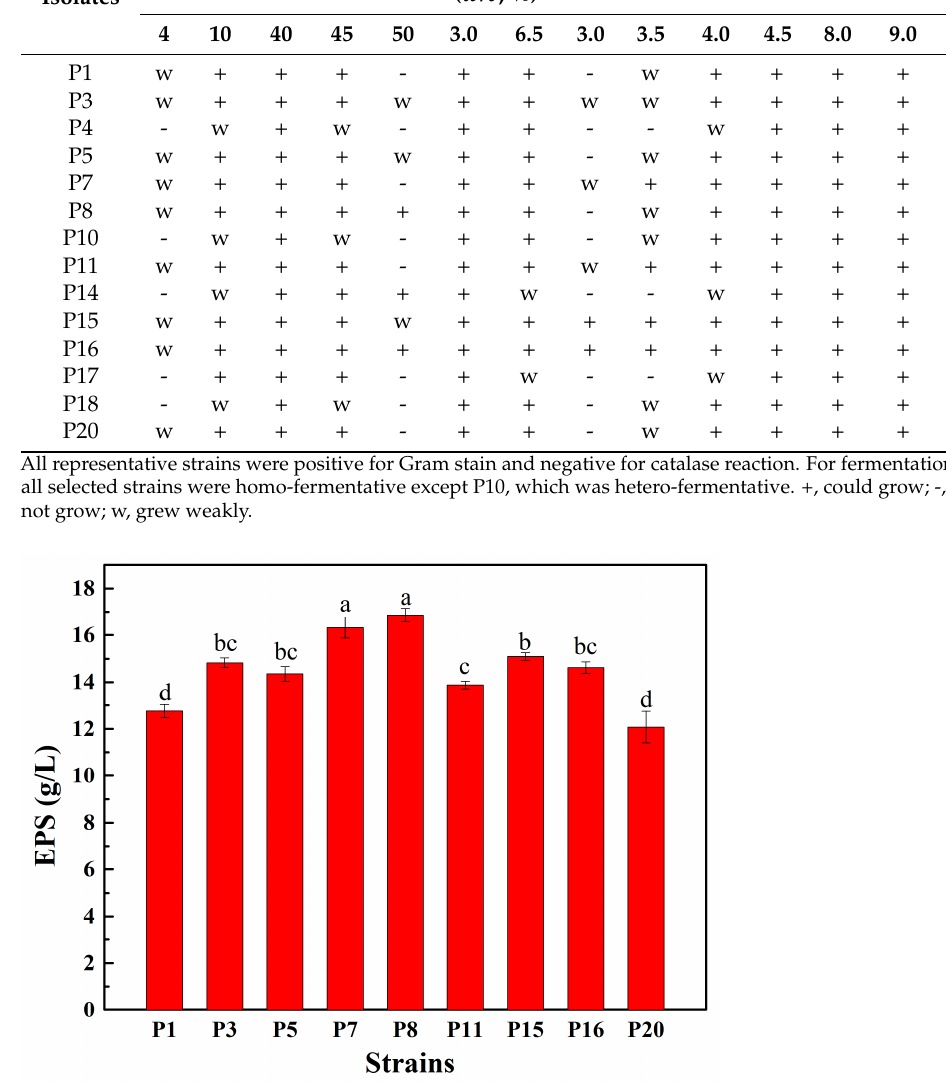
Figure 1. The EPS production capacity of representative LAB isolates. Different lowercase letters (a, b, c, d) denote significant differences ( p < 0.05), and results were expressed as mean ± standard deviation (SD) ( n = 3).